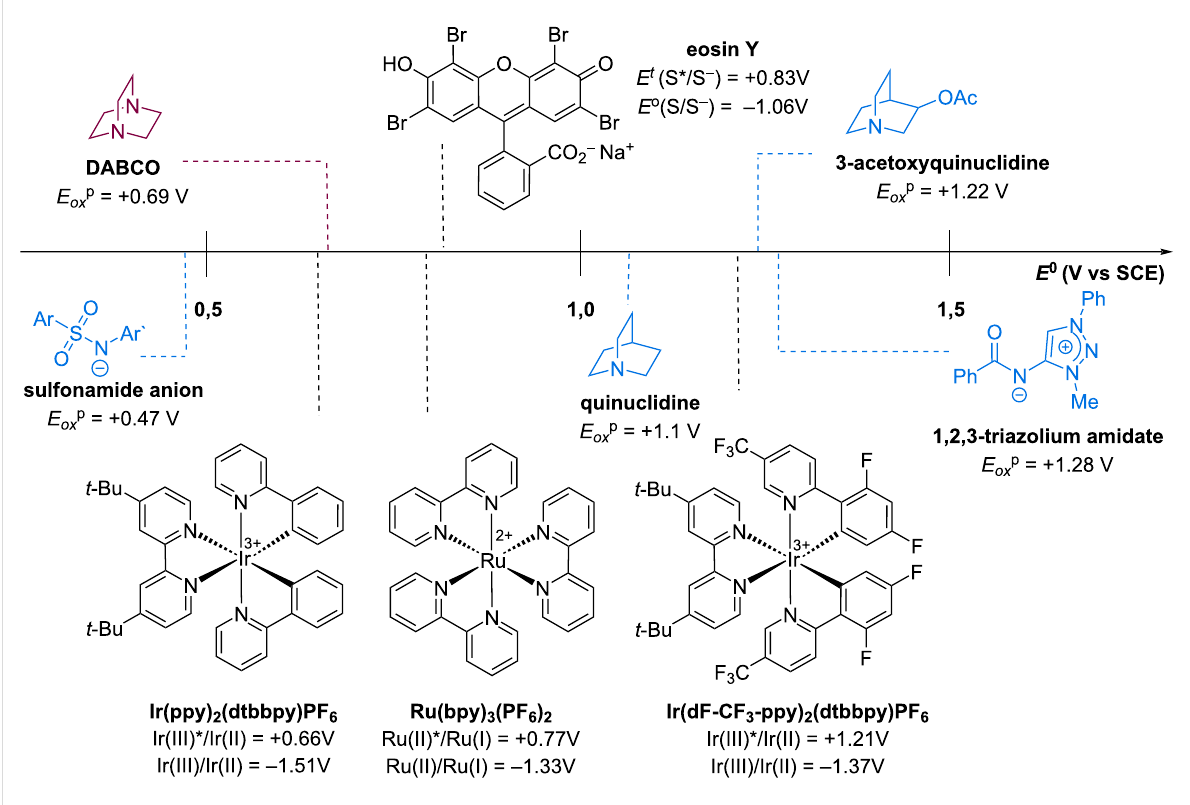
Figure 1: Redox potentials of representative nitrogenated HAT catalysts and photocatalysts